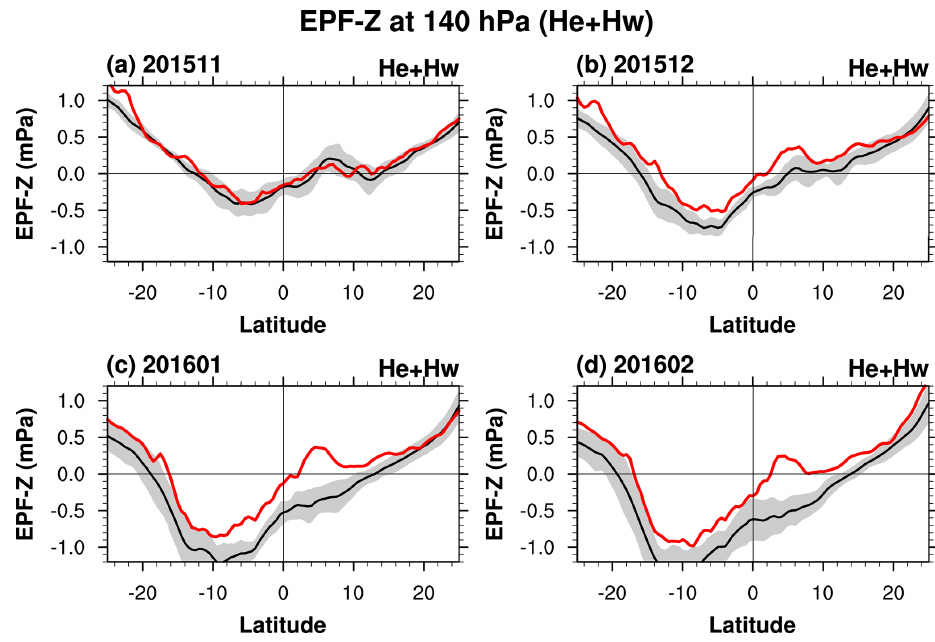
Figure 12. Vertical EP flux at 140hPa for the H e + H w waves ((i) | k | > 20 and ω > 0cpd or (ii) | k | ≤ 20 and ω > 0 . 4cpd; approximately for the IG waves) in (a) November 2015, (b) December 2015, (c) January 2016, and (d) February 2016 (red) and their monthly climatology (black) with ± 1SD (gray shading).